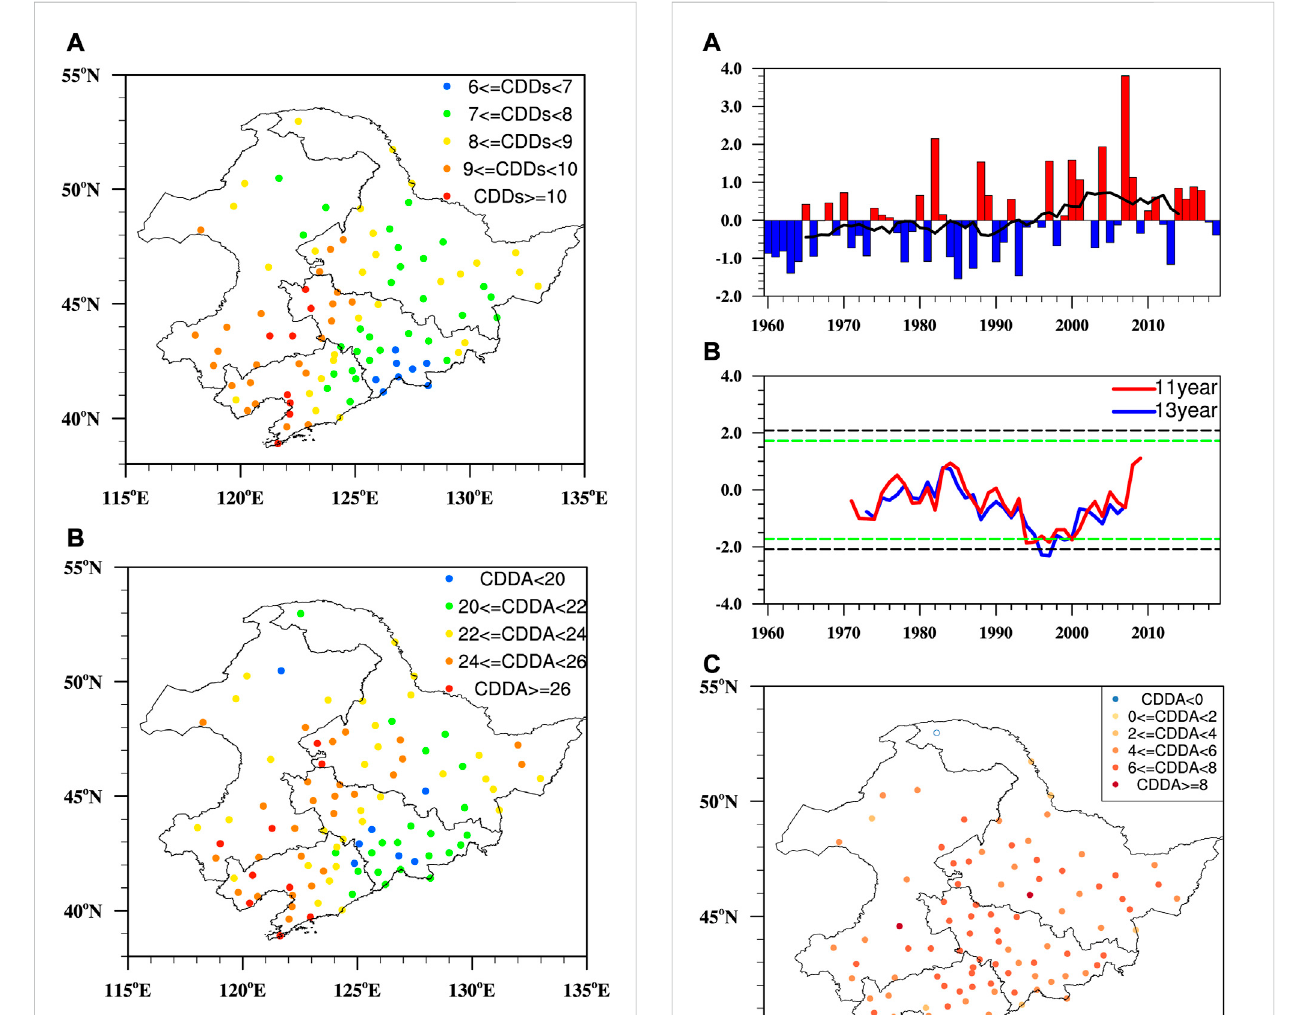
FIGURE 1 (A) The spatial distribution of the threshold (unit: day) of the summer extreme CDDs over NEC during 1960 − 2019. (B) The climatology of accumulated days of the summer extreme CDDs (CDDA; unit: day) over NEC during 1960 − 2019.